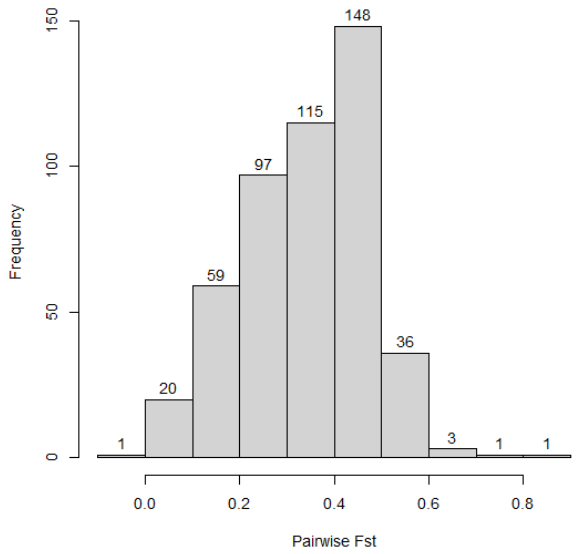
Figure 3. Accessions’ pairwise Fst value.